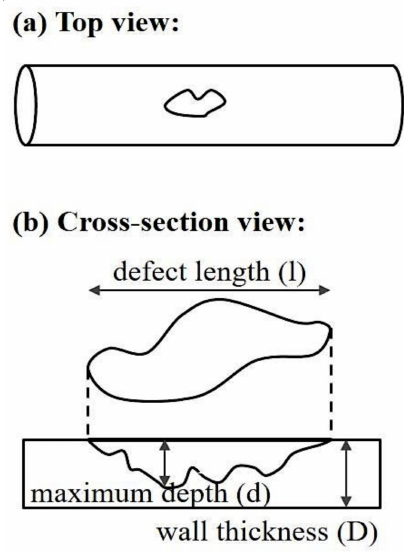
Figure 2. A rectangular-like corrosion defect in the pipeline in ( a ) top view and ( b ) cross-section